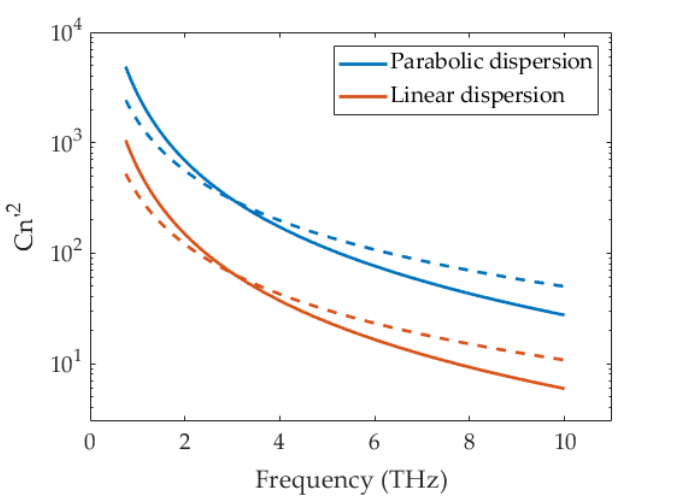
Figure 3. Comparison of the low-field (solid) and high-field (dashed) approximations for Cn (cid:48) 2 in parabolic and linear